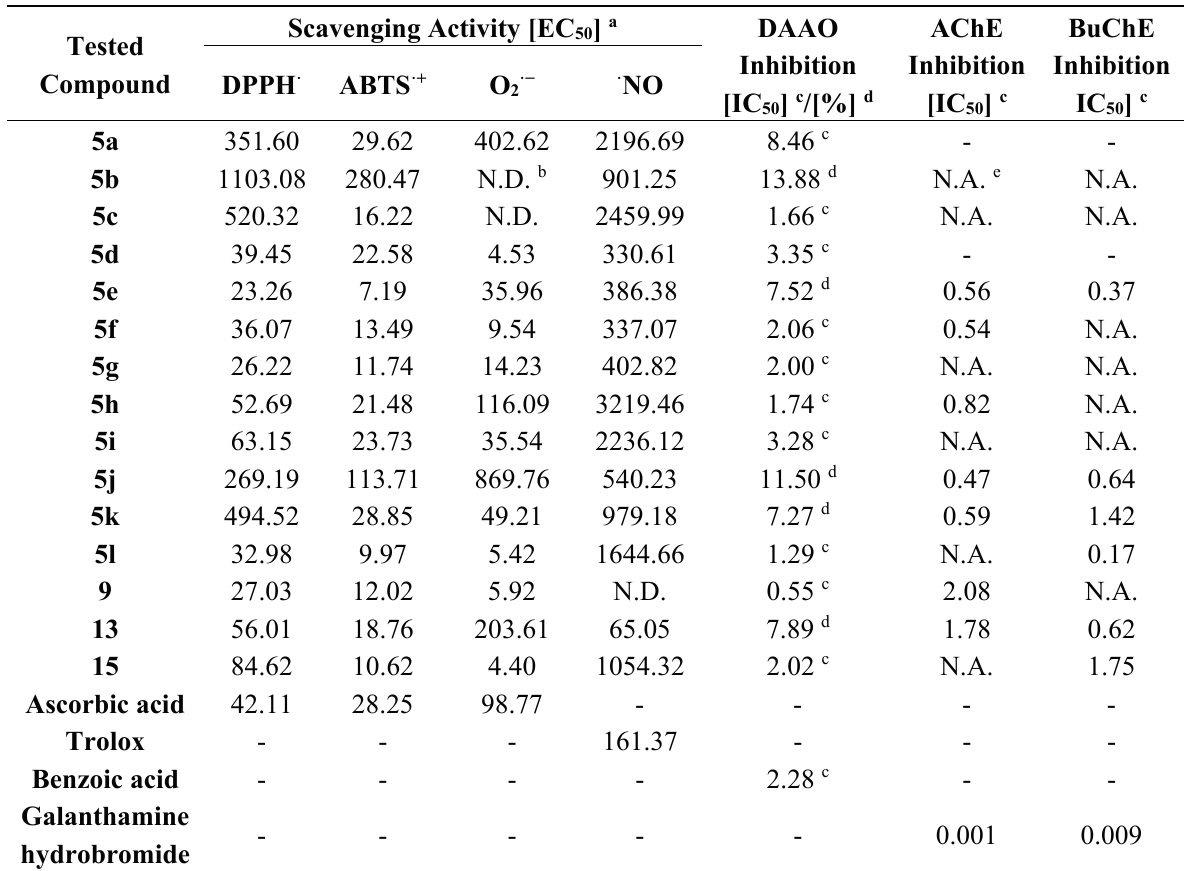
Table 3. Biological activities of synthesised